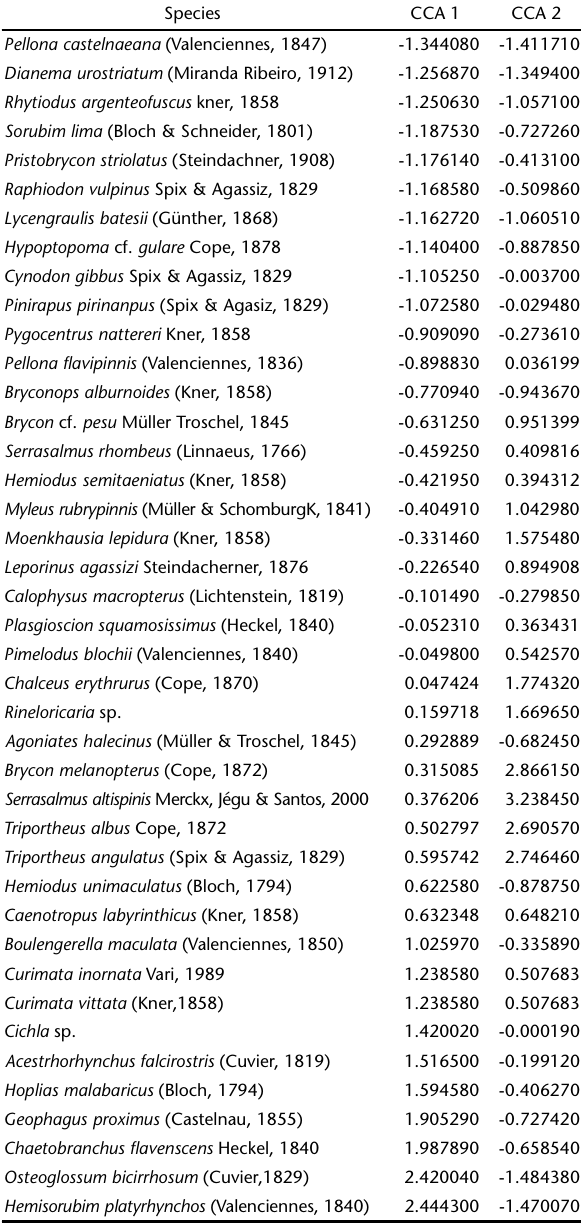
Table 3. Scores on axis 1 and axis 2 based on the matrix of species assemblage composition and the matrix of habitat variables in periods of drought and flood in the Urucu River, Municipality of Coari, AM,